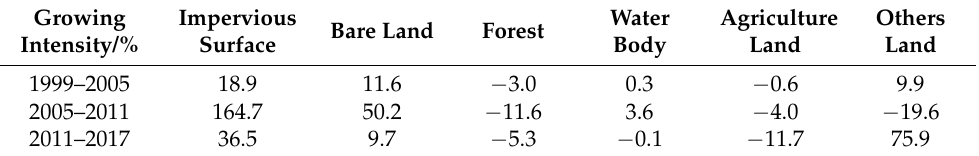
Table 2. The growth intensity index of different types of